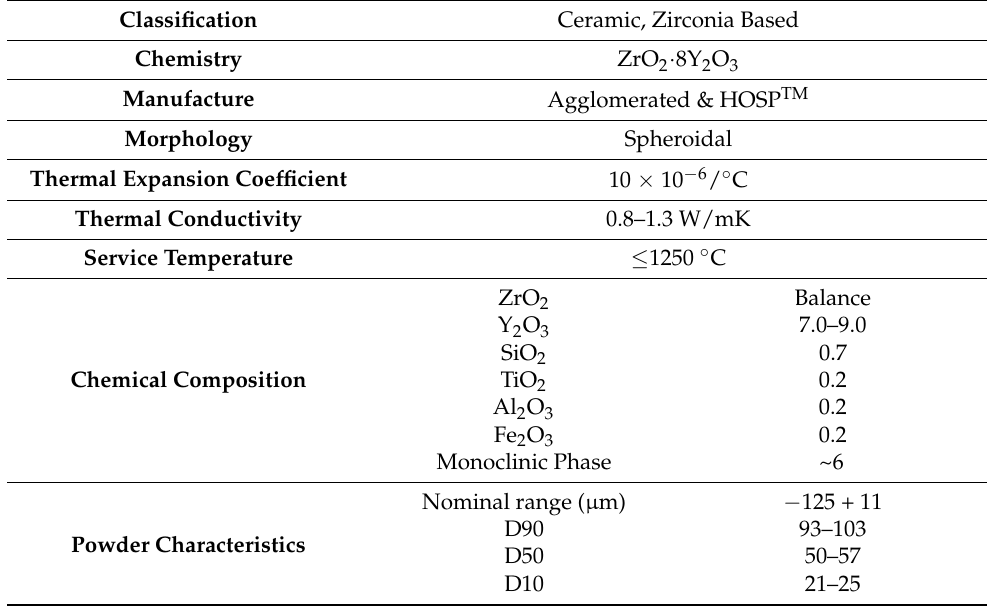
Figure 7. SEM photomicrographs (1000 × of magnification) of YSZ powder morphology [23]. Table 3. YSZ Material (Oerlikon Metco, Shanghai, China) Characteristics.